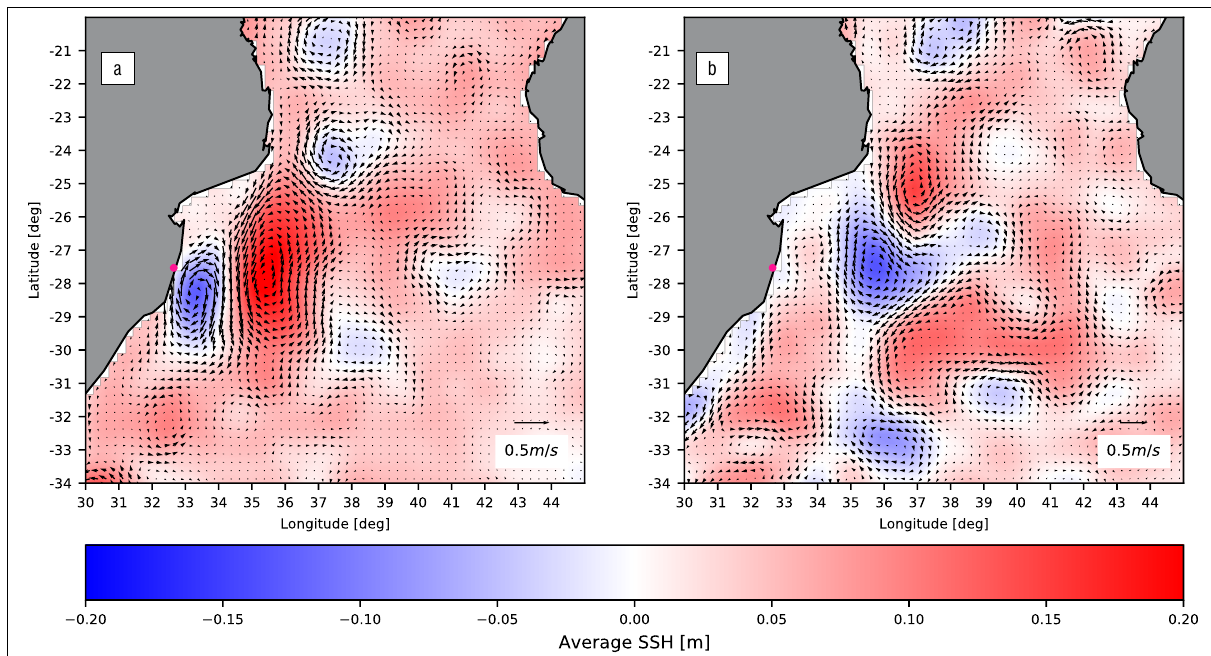
Figure 9: (a) Conditionally averaged sea surface height (SSH) field at the peak of the temperature anomalies with positive cross-correlation coefficients. (b) Conditionally averaged SSH field at the peak of the temperature anomalies with negative cross-correlation coefficients. Geostrophic currents have been overlaid as a quiver plot and are scaled by